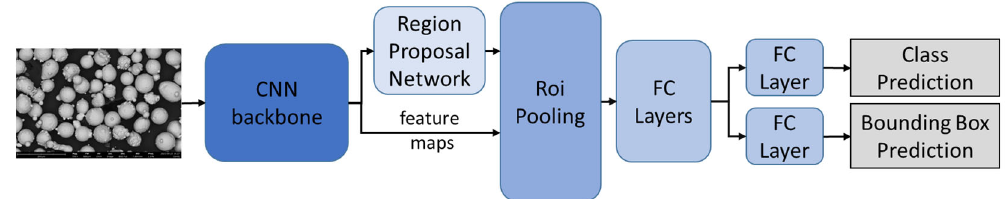
Figure 1. The faster R-CNN architecture; the information flows from left to right.